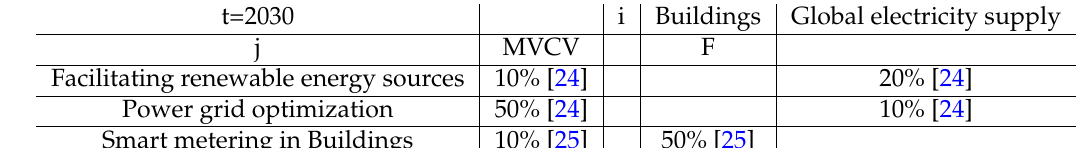
Table 7. Smart Grid saving ICT Technologies